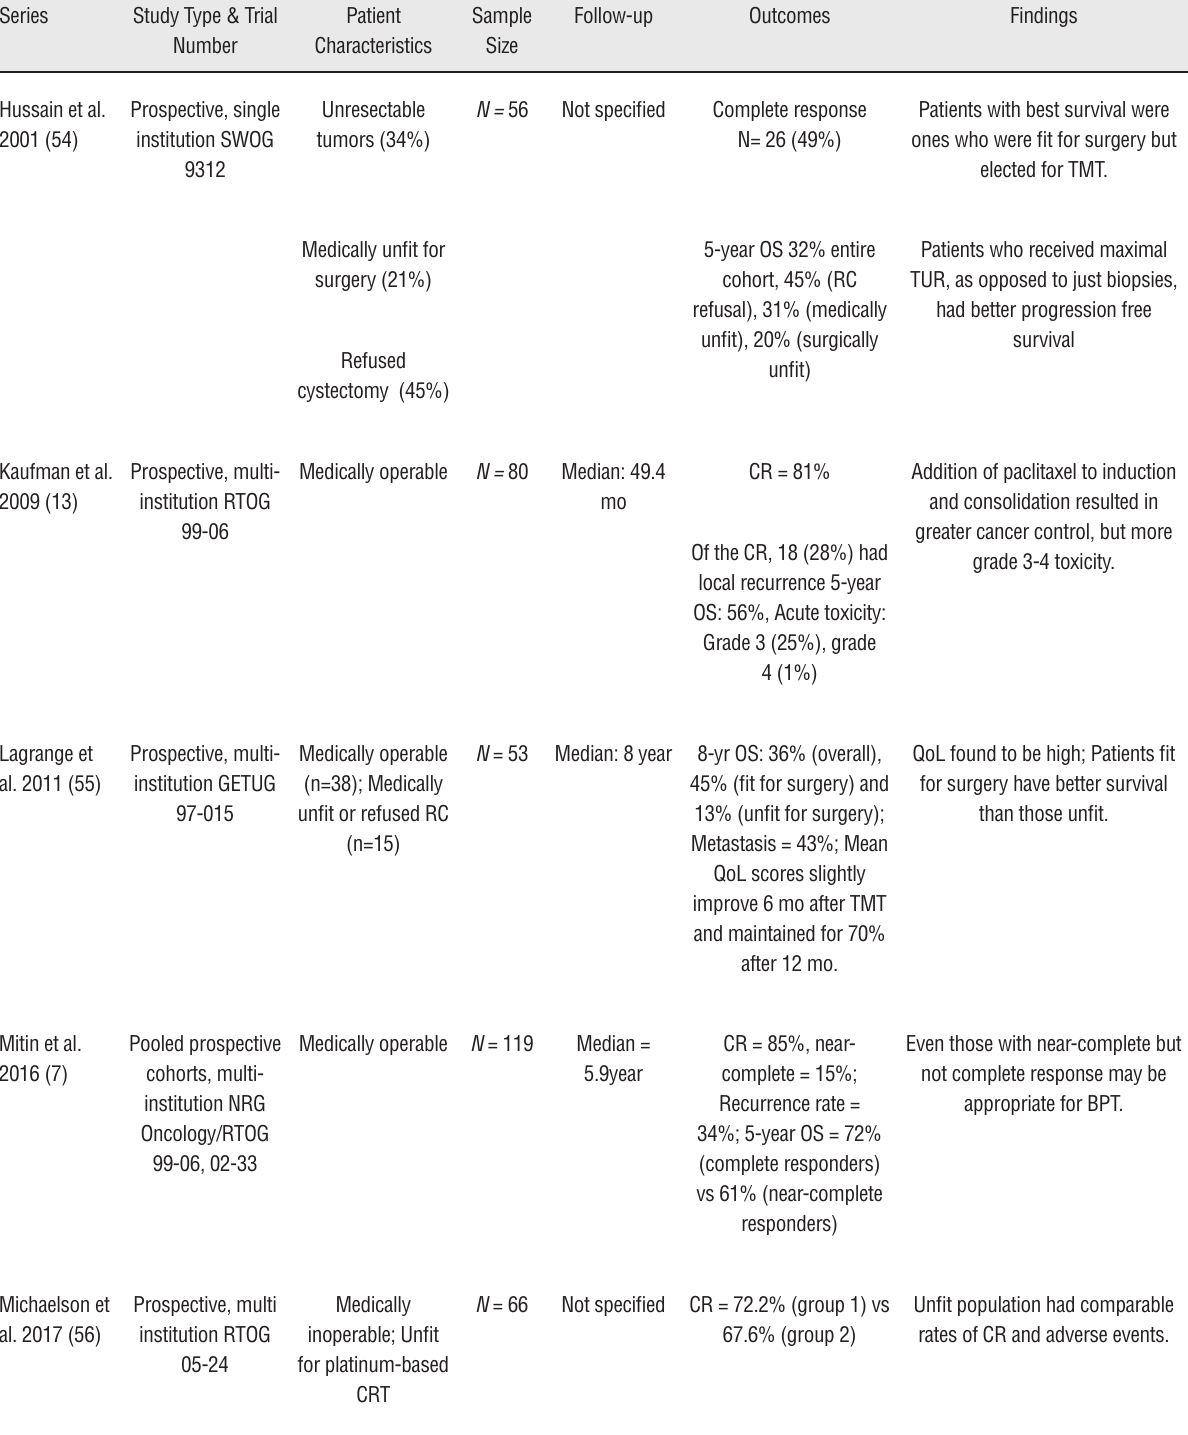
Table 2 - Prospective trimodal therapy